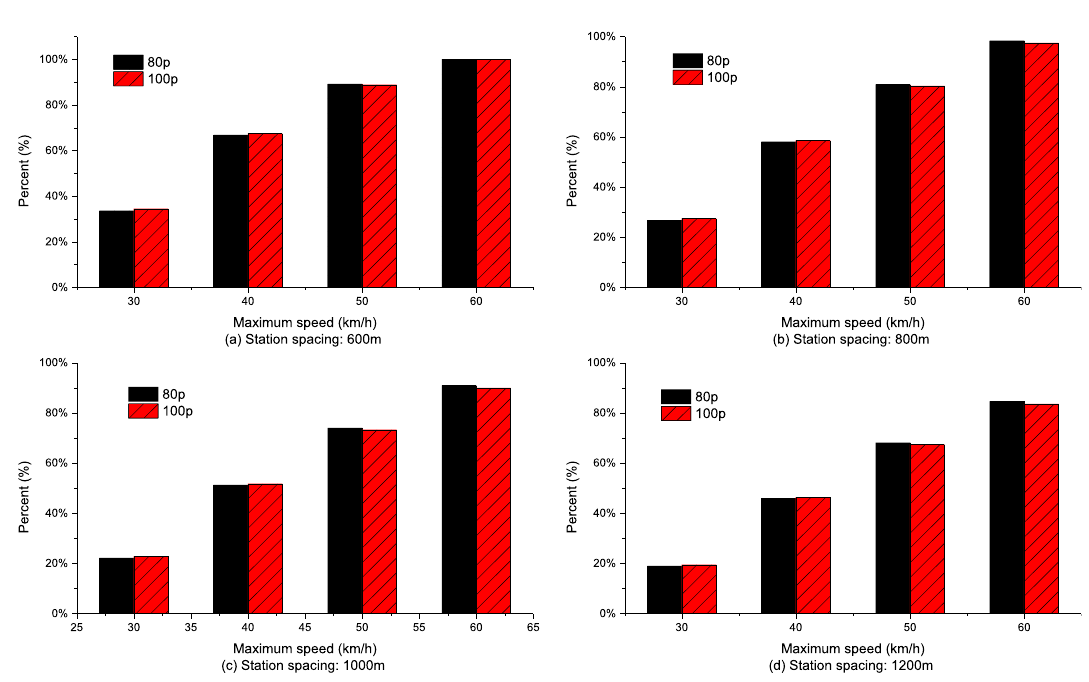
v = 0.8 m/s 2 d t